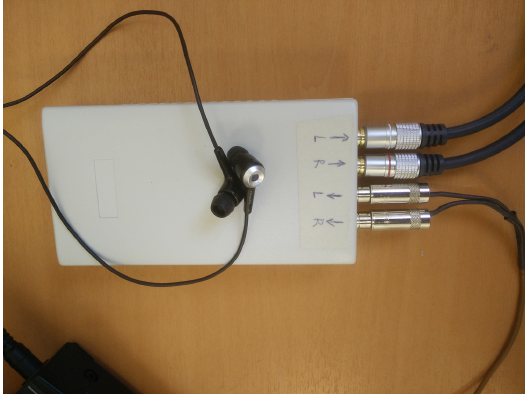
Figure 11. ARA headphones and preamp.